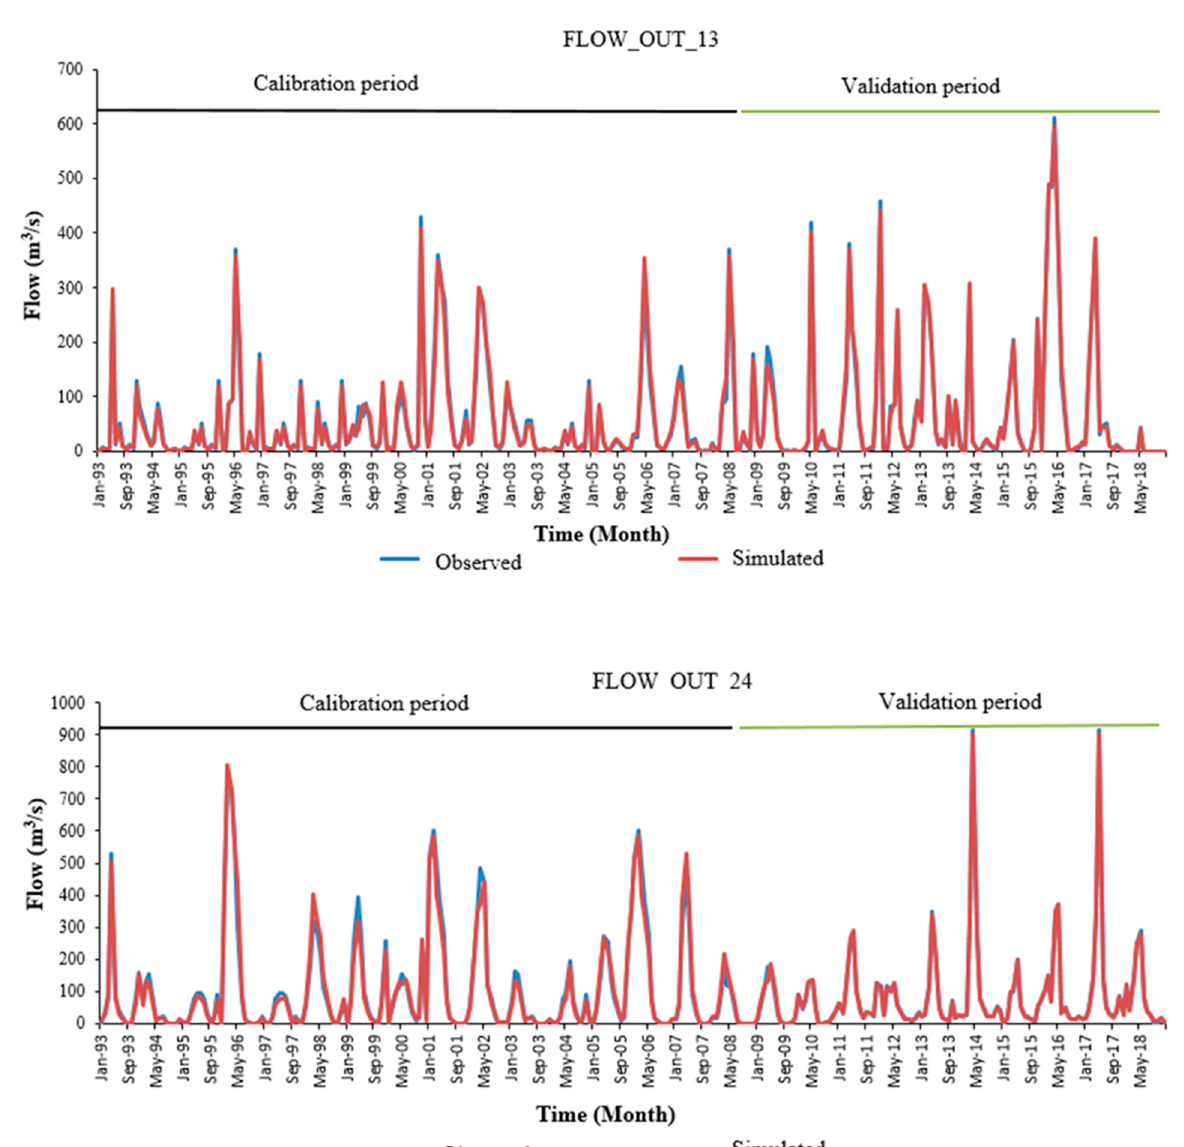
Figure 14. The hydrographs of the observed and simulated monthly water flow for the calibration and validation periods . Table 11. The model performance statistics for calibration and validation in the two outlets of the WRB.